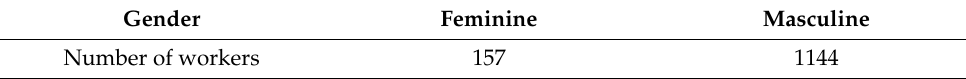
Table 6. Number of workers by gender. Gender Feminine Masculine Number of workers 157